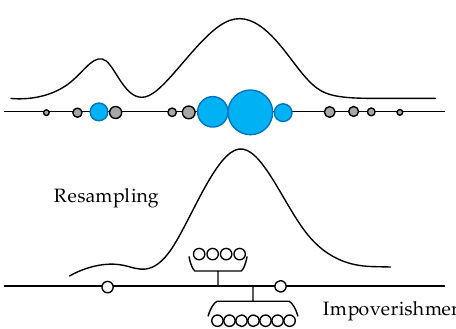
Figure 1. The particle impoverishment phenomenon caused by resampling